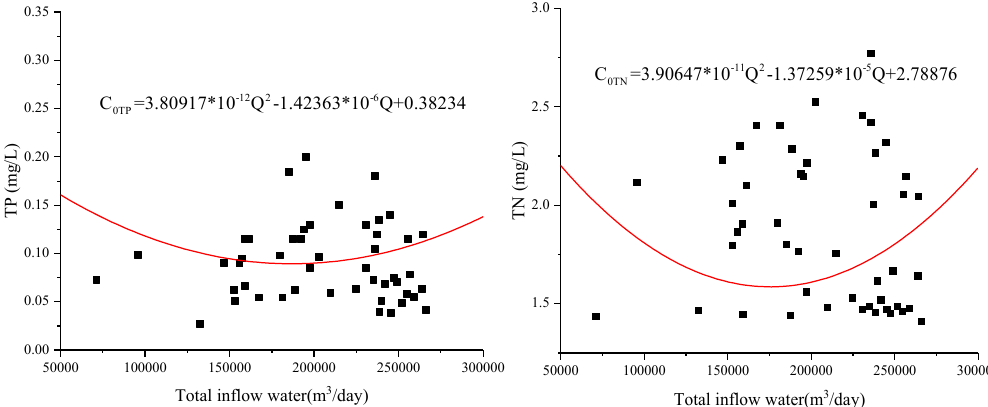
Figure 11. Relationship between diversion water concentration and total inflow We fit each scatter plot to a quadratic function. The equation is: C = Intercept + B1* Q + B2* Q 2 , C is the water quality concentration, Q is the inflow discharge, and Intercept, B1, and B2 are all constant parameters. The Intercept for each curve (left to right) is: 0.3823, 2.7888. The B1 for each curve (left to right) is: − 1.4236 × 10 − 6 , − 1.3726 × 10 − 5 . The B2 for each curve (left to right) are: 3.8092 × 10 − 12 , 3.9065 × 10 − 11 . The coefficient of determination, R-squared, for each curve (left to right) is: 0.3643, 0.2108.